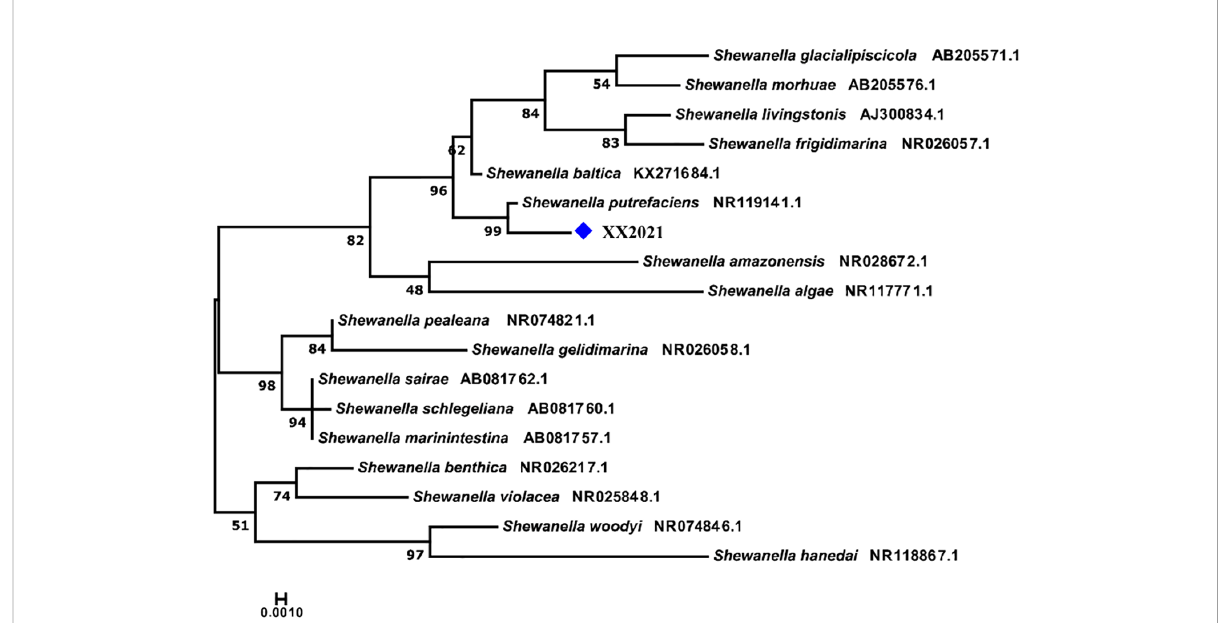
FIGURE 3 Neighbor-joining (NJ) phylogenetic tree constructed based on the 16S rRNA nucleotide sequences of Shewanella species. The percentage of bootstrap values is shown next to the branches based on 10,000 bootstrap replications. The XX2021 sequence is indicated by the blue